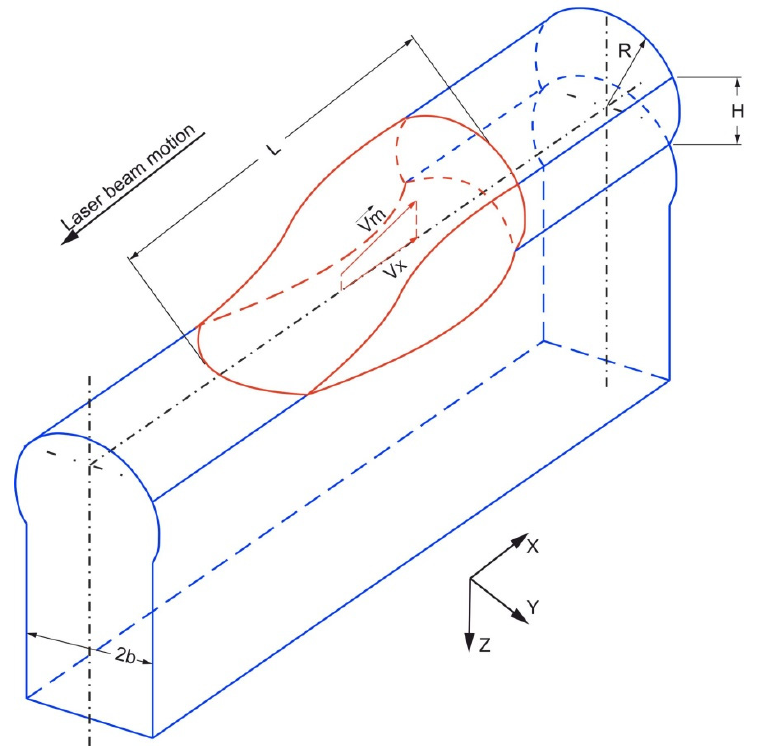
Figure 1. Design diagram of the deposited wall and the melt